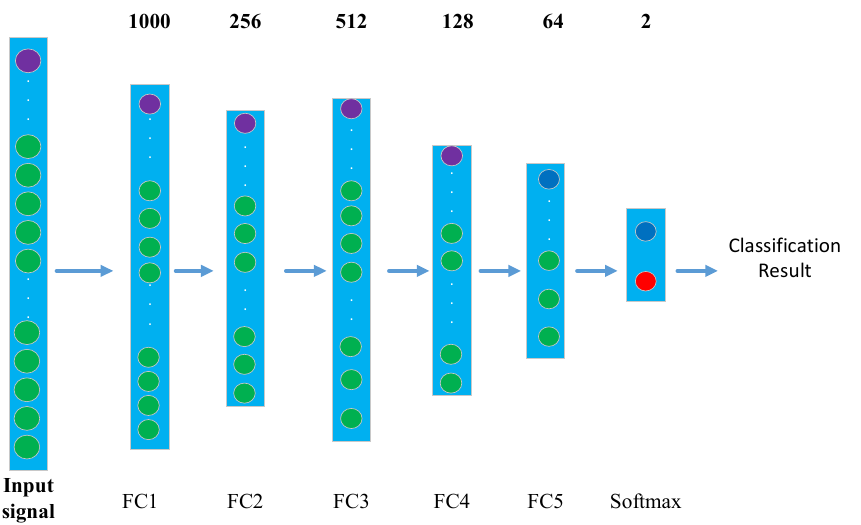
Figure 5. Binary classification with the approach of FFT+DNN.